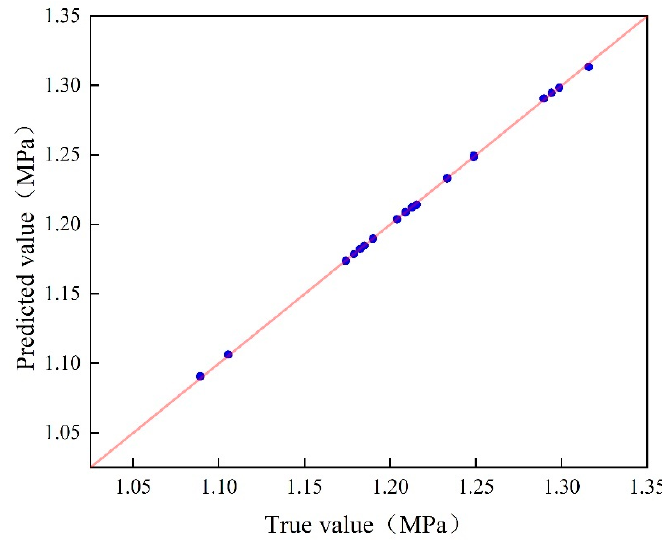
Figure 8. Comparison between the predicted and true value of K c .